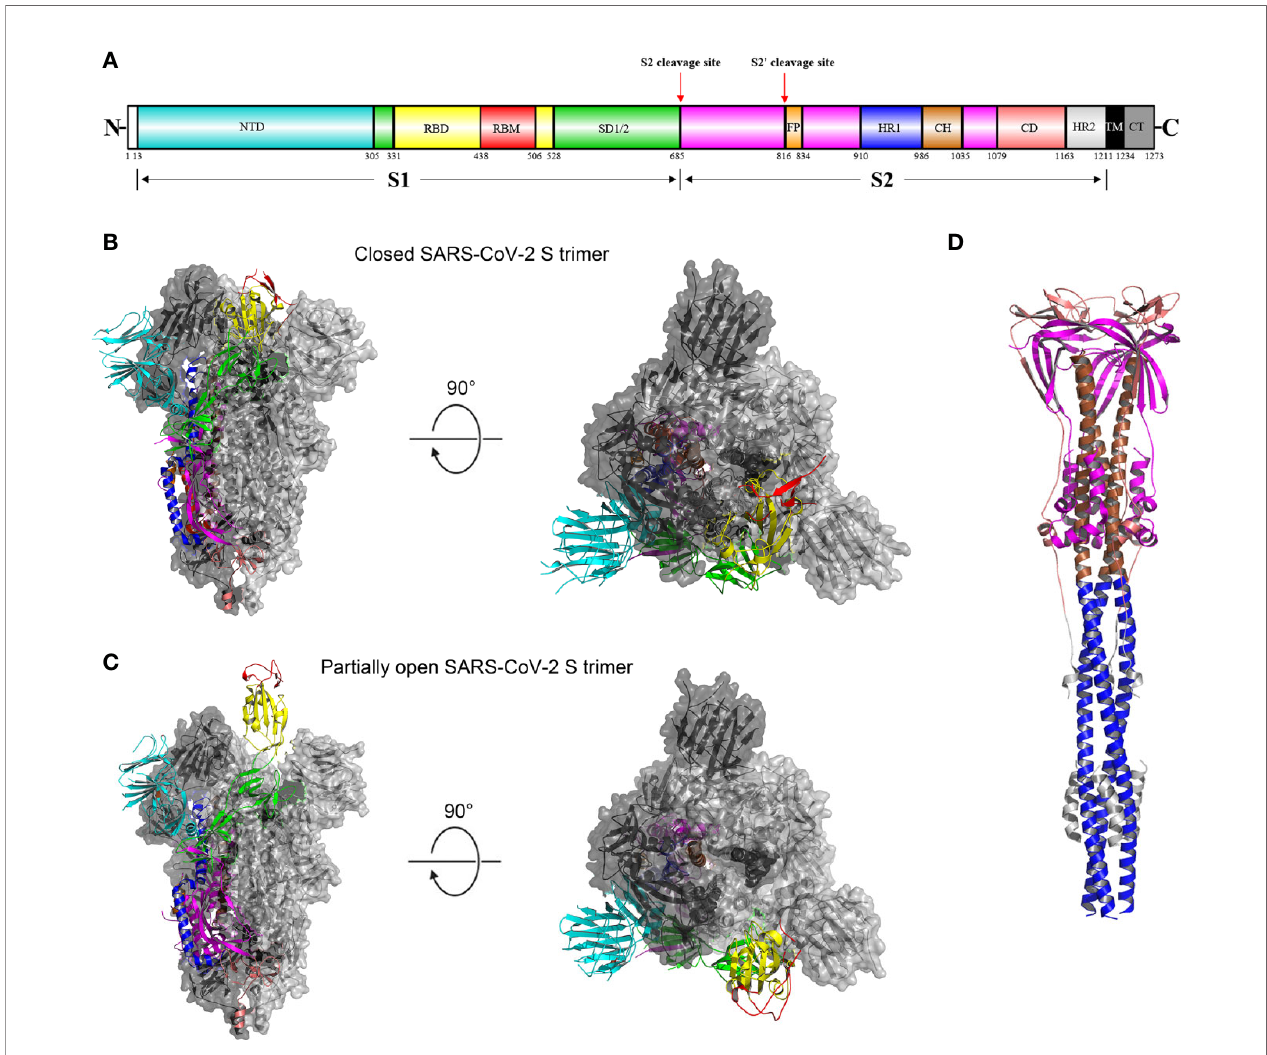
FIGURE 2 | Overall structures of the SARS-CoV-2 S glycoprotein trimer in different conformations. (A) Schematic representation of the domain arrangement of the SARS-CoV-2 S protein precursor. SS, signal peptide; NTD: N-terminal domain; RBD: receptor-binding domain; RBM: receptor-binding motif; SD1/2: subdomain 1 and 2; FP, fusion peptide; HR1, heptad repeat 1; CH, central helix; CD, connector domain; HR2, heptad repeat 2; TM, transmembrane domain; CT, cytoplasmic tail. Arrows denote protease cleavage sites. (B) Side and top views of the prefusion structure of the SARS-CoV-2 S ectodomain trimer with all three RBDs in the down conformation (PDB ID: 6VXX). One protomer is shown in ribbon representation colored corresponding to the schematic in (A) , a second protomer in light gray surface representation, and the third protomer in dark gray surface representation. (C) is identical to (B) except that a single RBD assumes the up conformation